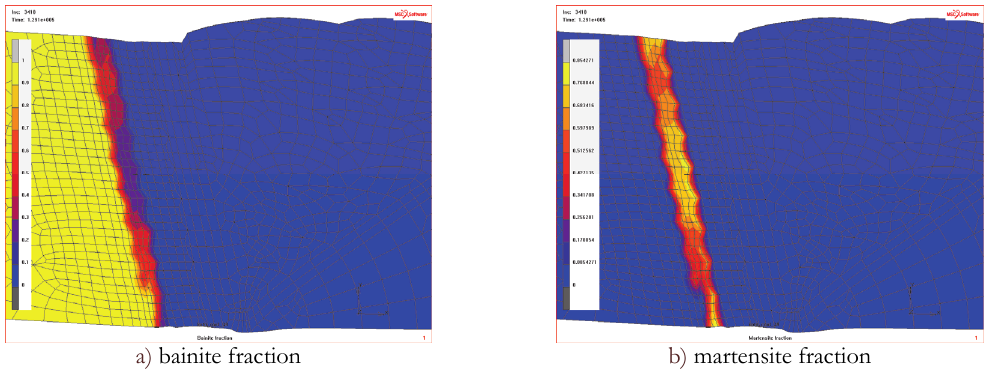
Figure 9: Fraction of each phase after welding